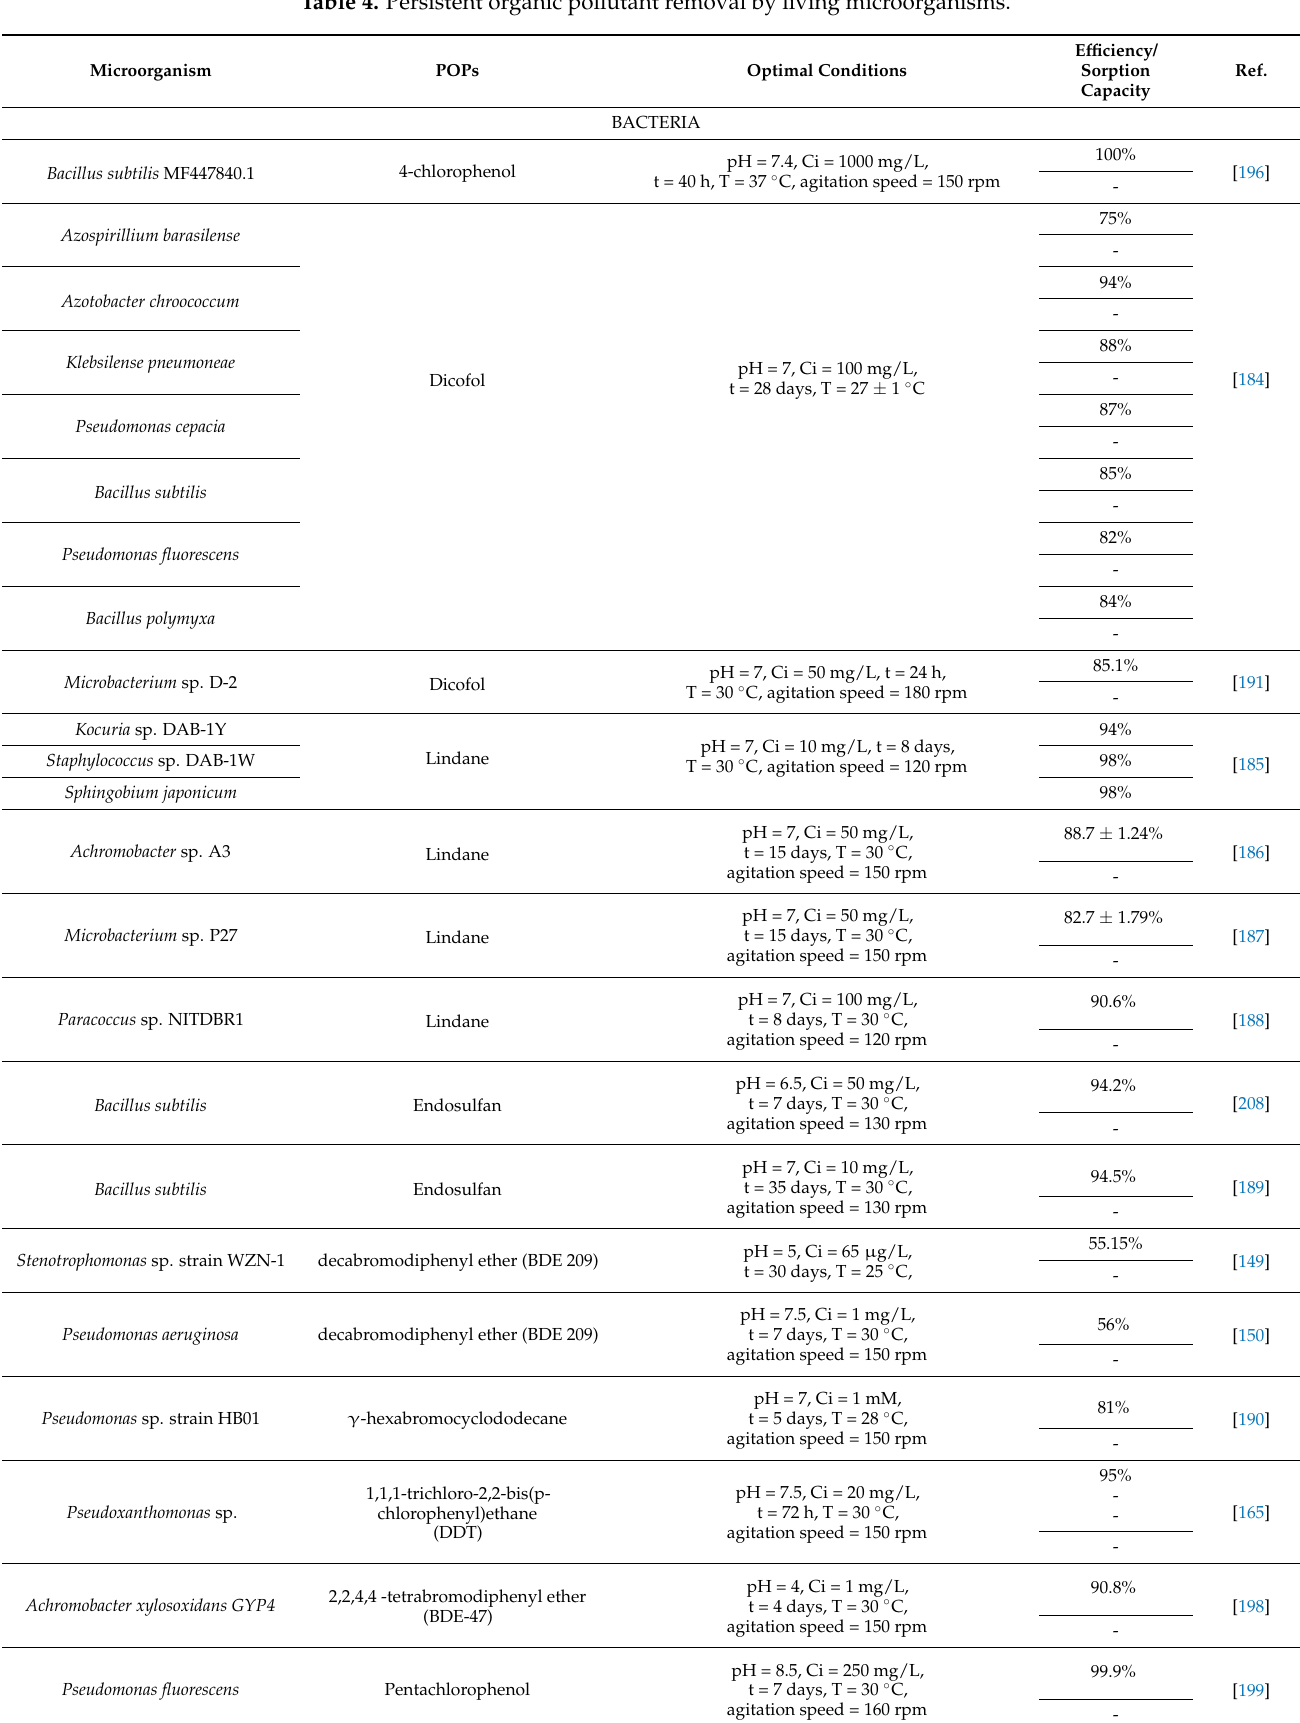
Table 4. Persistent organic pollutant removal by living